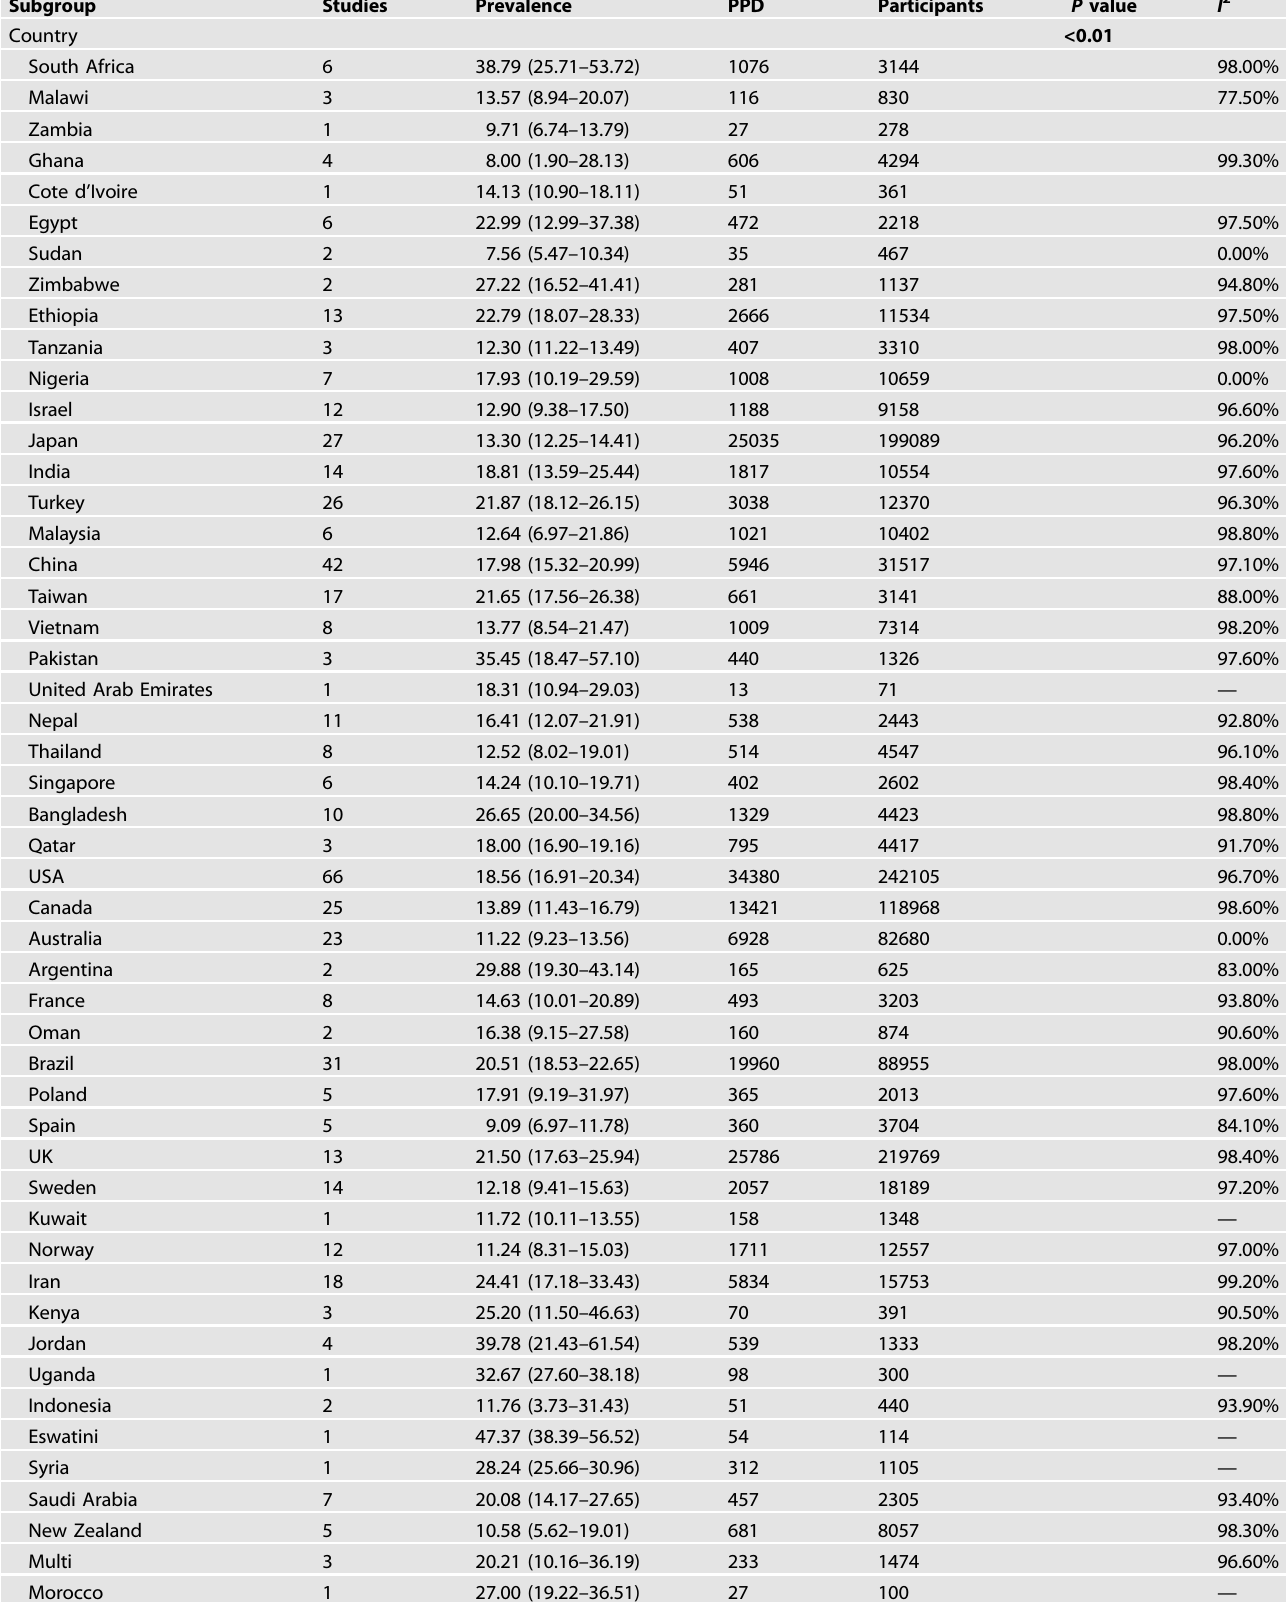
Table 1. Subgroup analysis for PPD prevalence among